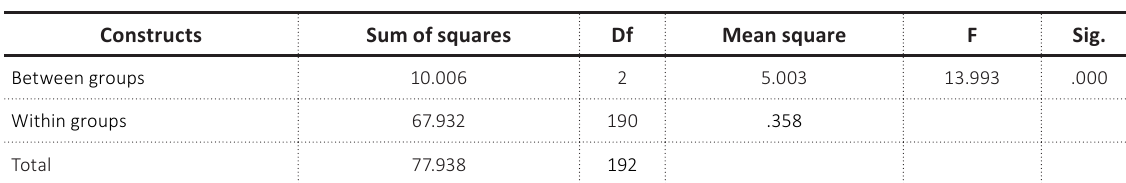
Control of financial fraud in